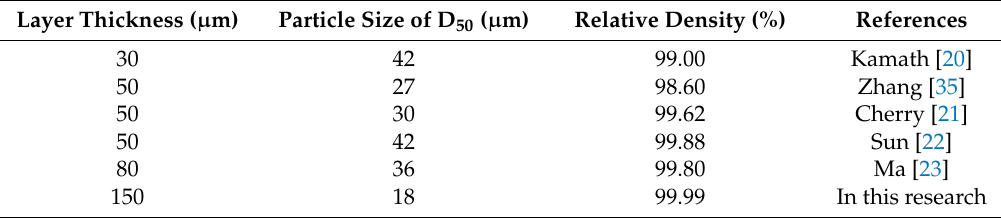
Figure 6. Schematic of coarse powder with hollows and voids. Table 4. Summary of different particle sizes in previous